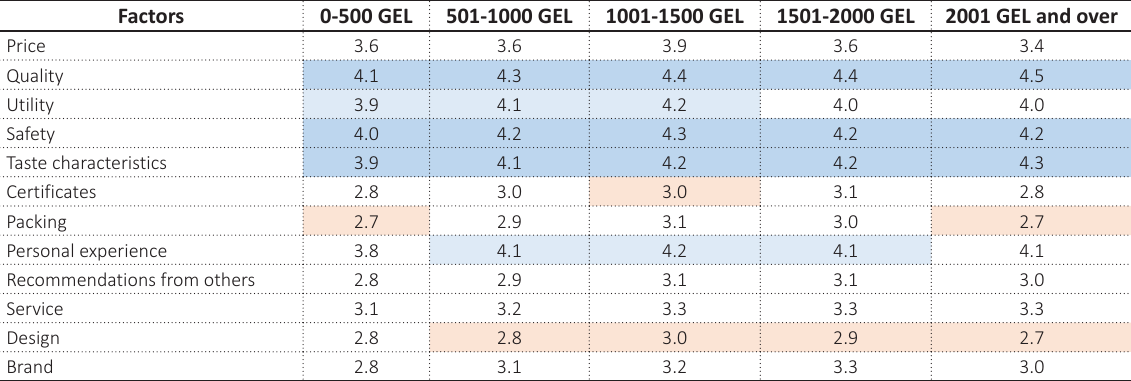
Table 7. Results to the question: Please, rate the following factors according to their importance in choosing agri-food products with scores (1 – the lowest, 5 – the highest). Seen in terms of revenue (average